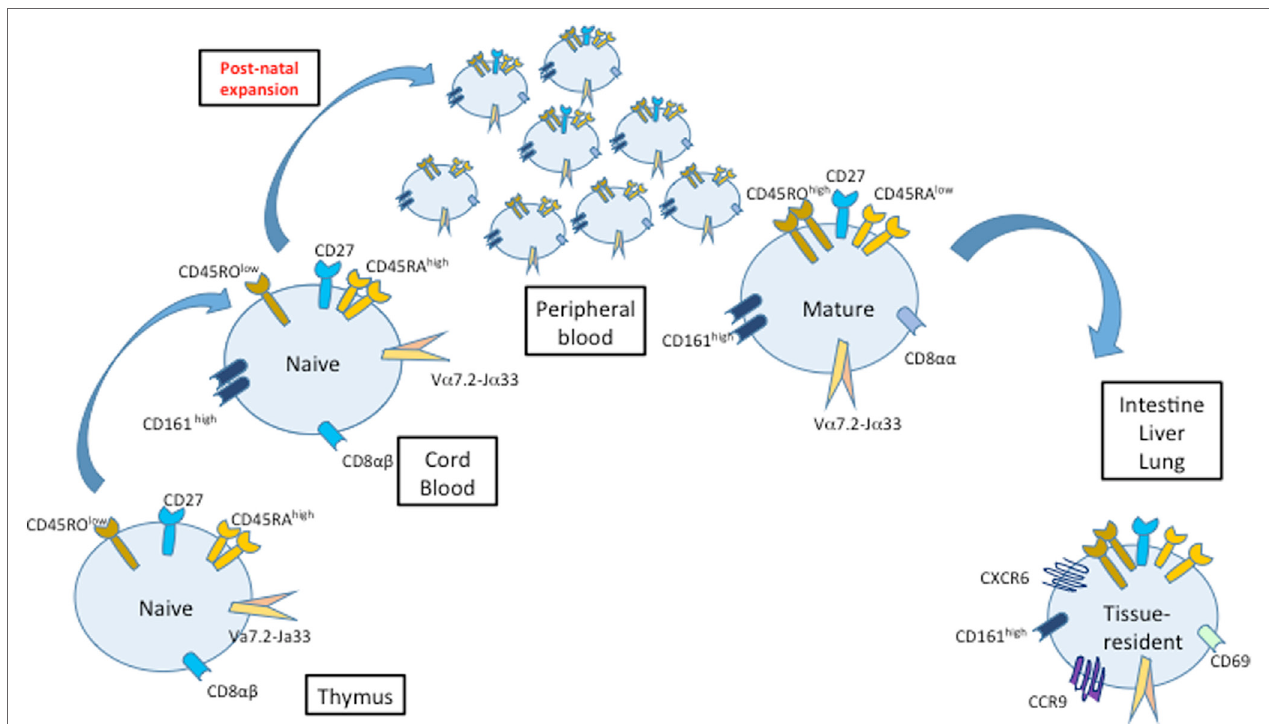
FigURe 2 | Maturation, proliferation, and migration of mucosal-associated invariant T (MAIT) cells. MAIT cells have a naive phenotype (CD45RA high /CD27/CD45RO lo ) and a low frequency in cord blood compared with adult peripheral blood. Classically, MAIT cell development in the thymus is divided into three stages defined by their expression of CD161 and CD27, with stage 3 MAIT cells resembling MAIT cells found in peripheral blood after birth. After the birth, MAIT cells proliferate and acquire a mature phenotype. The colonization of different organs starts already during fetal